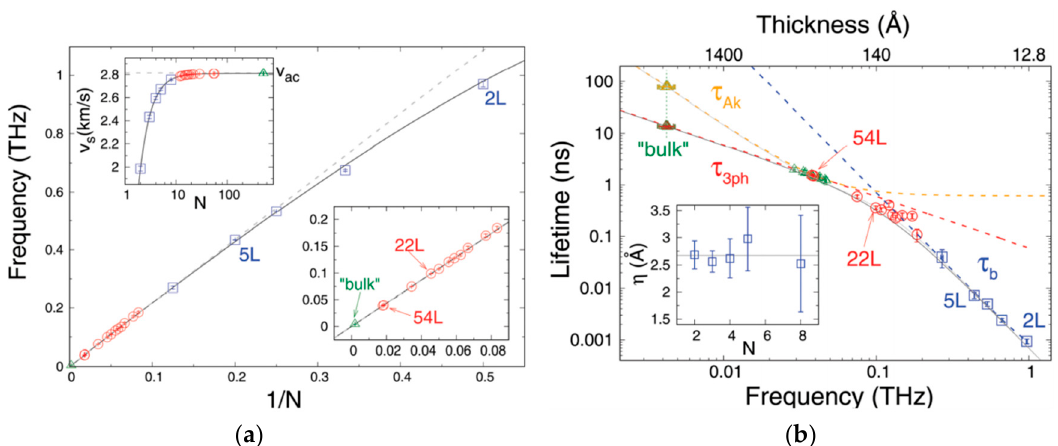
Figure 8. ( a ) RCP frequency extracted from time-domain measurements on suspended MoSe 2 slabs. Evolution with the number of layers diverge from Equation (9) shown in dashed line to follow Equation (2) shown in solid line for few-layer samples. Extracted acoustic velocity is presented in top inset. ( b ) Corresponding lifetime which follow two different regimes discussed in the main text. Inset shows the average asperity size at the surface extracted from fit to few-layer data. Republished with permission of Royal Society of Chemistry, from [132] Copyright © 2019. Permission conveyed through Copyright Clearance Center, Inc.